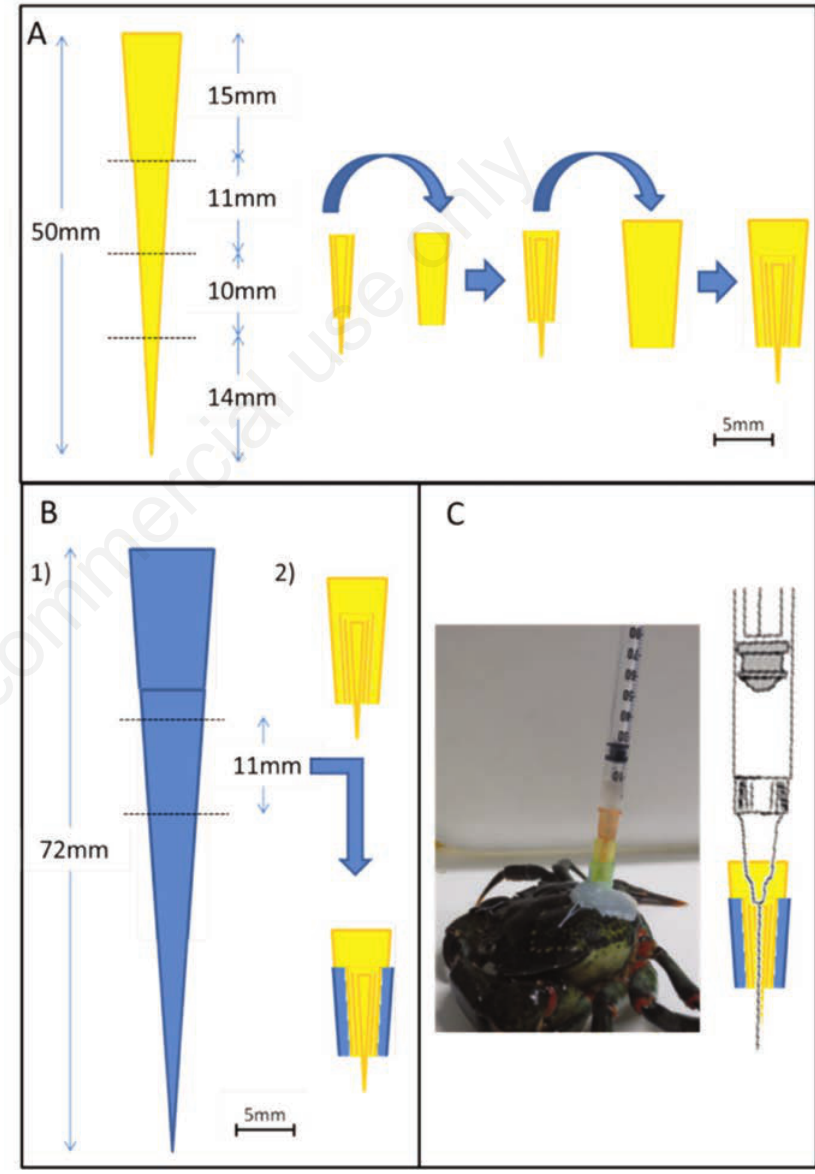
Figure 1. Injection device: graphical depiction of fabrication using 200 µL and 1000 µL pipette tips. A) Cutting and assembly of parts derived from the 200 µL tips. B) 1. Withdrawal of an 11 mm middle section from a 1000 µL tip and 2. completion of the injection device. C) Shore crab equipped with injection device fixed with epoxy on his carapace and schematic representation of the inserted